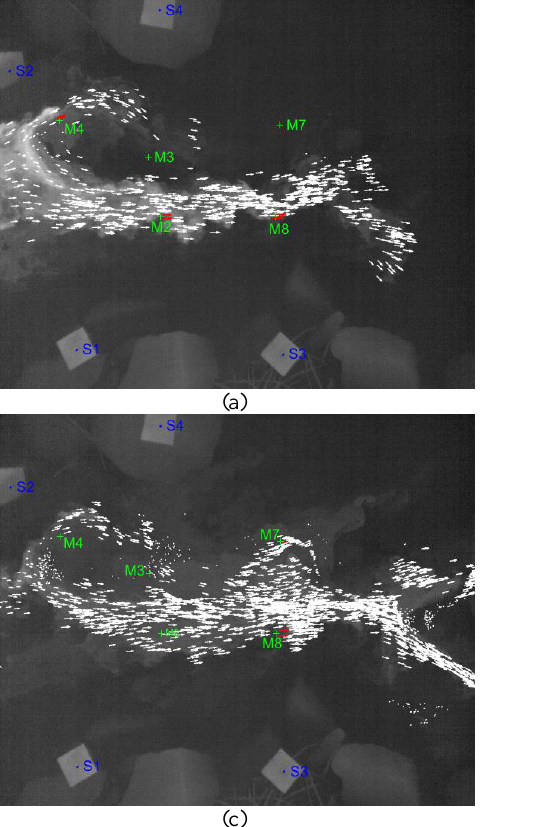
Figure 9. Tracking Results: (a), (b), (c) and (d) show velocity measurement results on 97 th , 143 rd , 181 st and 212 nd image respectively, white arrows show the magnitude and direction of all the velocity vectors, red arrows show the candidate results selected by the threshold b